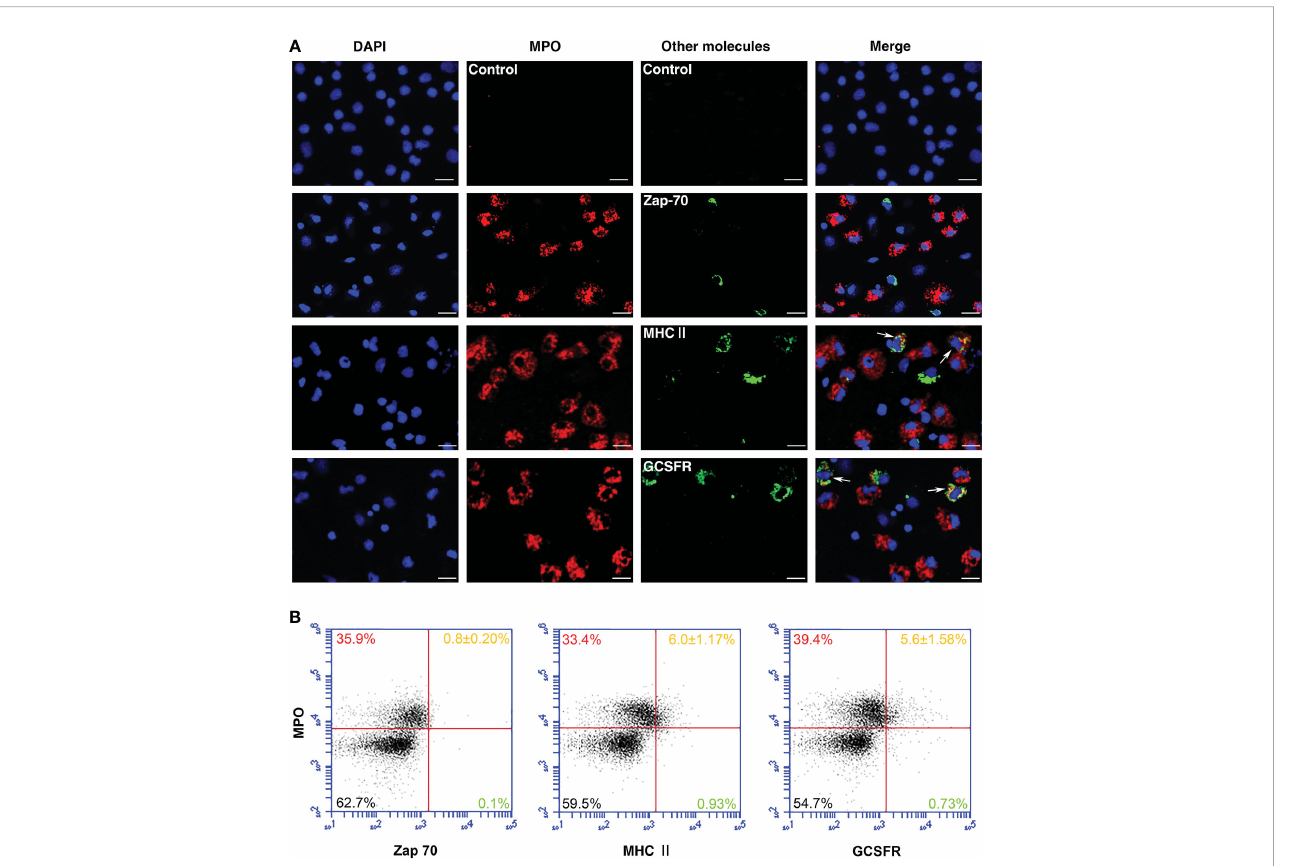
FIGURE 5 Identi fi cation of MPO + cells in fl ounder. (A) Peritoneal cells were double-stained using anti-r Po MPO Abs (red) and anti-Zap-70, anti-MHCII, or anti- GCSFR Abs (green), respectively. The blue color showed the DAPI dye nuclei. Arrows indicated double-positive cells. Bar = 10 µm. (B) Peritoneal cells were double-stained and analyzed by fl ow cytometry. Each fi gure is representative from three analysis (mean ± SD, n = 5).